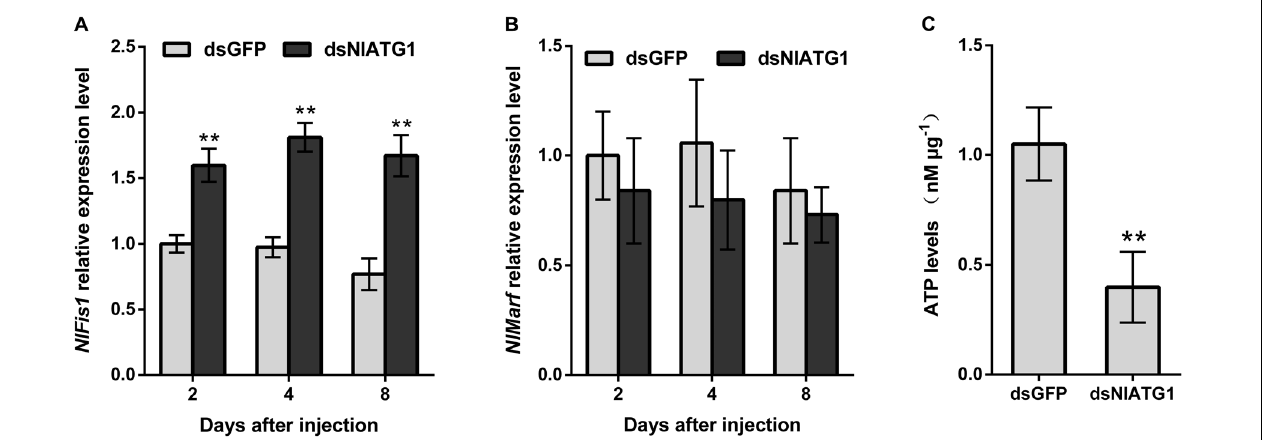
FIGURE 8 | Relative expression level of the mitochondrial fission gene NlFis1 and fusion gene NlMarf , and the ATP content of BPH. (A) Expression level of NlFis1 gene. (B) Expression level of NlMarf gene. (C) The ATP content. BPH individuals were treated with dsRNA for 4 days. All values are presented as the mean ± SD of three independent biological replicates (** p <